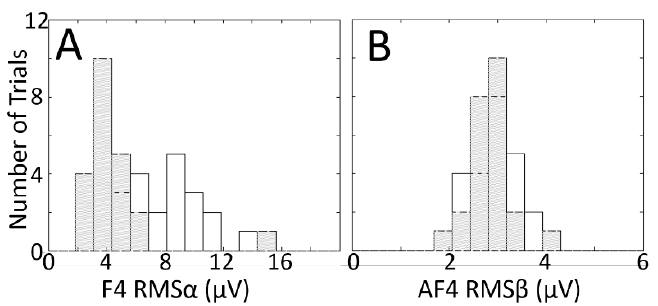
Figure 10. Histograms showing the distributions of RMS voltage across trials (color–word stimulus presentations) in one congruent (grey hatched) and one incongruent (white) experimental session pair, for one electrode–RMS feature combination that shows relatively good class separation ( A ) and one that shows relatively poor class separation ( B ). The electrode–RMS feature combinations illustrated in (A,B) correspond to the orange and black arrows, respectively, in Figure 9. Data in (A,B) are from two different subjects. Outliers in both panels are trimmed to avoid scaling issues that hamper visualization.